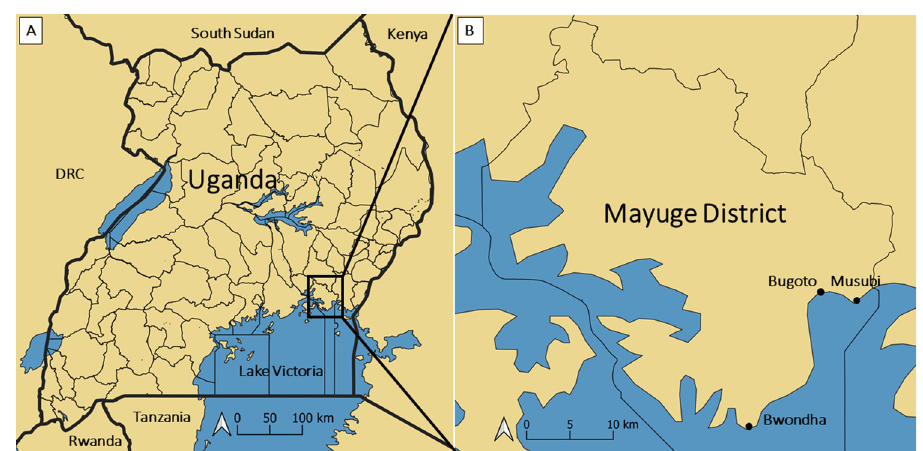
Fig 1. (A) Uganda map showing Mayuge District. (B) Mayuge District map showing the three study site villages: Bugoto, Bwondha and Musubi. Created using QGIS 3.14 Software (QGIS Association. QGIS Geographic Information System. 3.14 ed2020) using a base layer from Natural Earth (http://www.Naturalearthdata.com) for the reference maps, with district boundaries created using Uganda Bureau of Statistics (Uganda Bureau of Statistics (UBOS). Uganda Administrative Boundaries GIS Database. Kampala, Uganda: Government of Uganda, UBOS; 2006) [51].